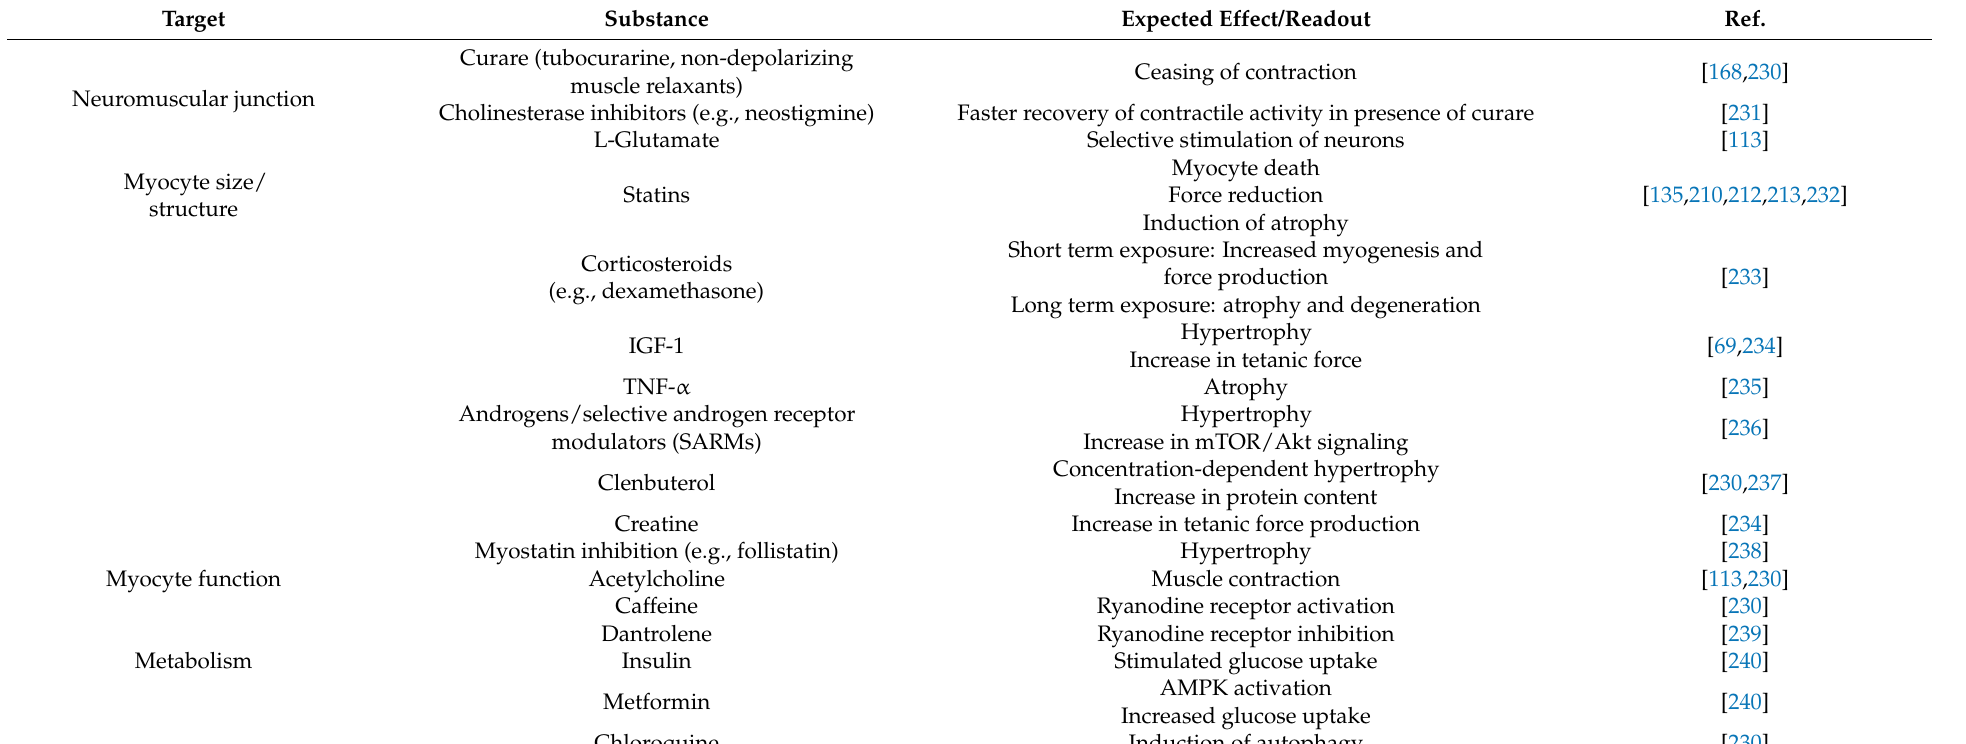
Table 2. List of proposed reference substances to validate neuromuscular in vitro